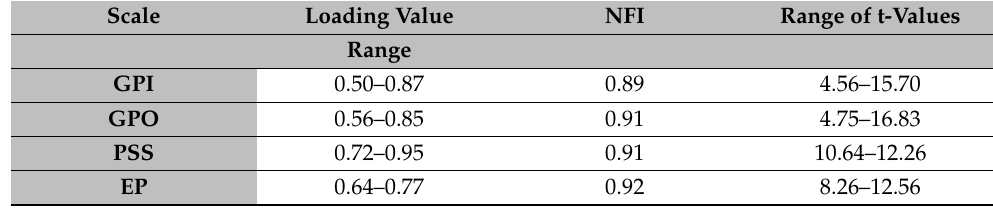
Table 5. Showing fit indices and